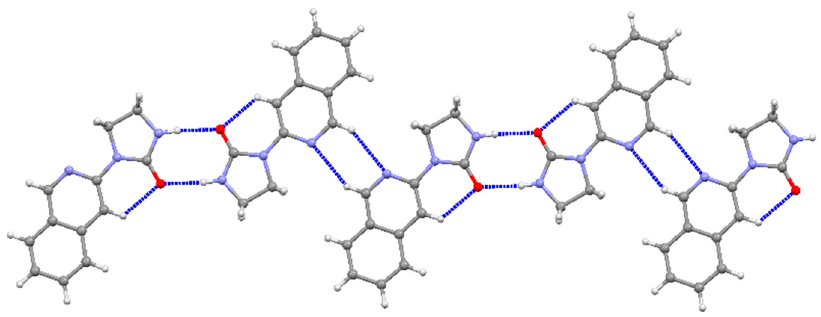
Figure 2. Tapes formed via N-H ··· O and C-H ··· N interactions in the crystal structure of 3e . Short Figure 2 . Tapes formed via N-H···O and C-H···N interactions in the crystal structure of 3e . Short contacts are indicated with dashed contacts are indicated with dashed lines.